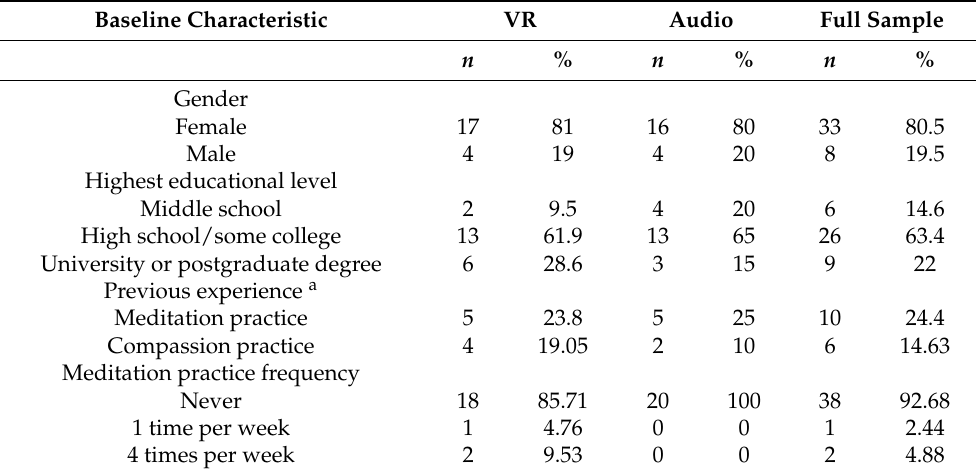
Table 1. Sociodemographic characteristics of participants at baseline.